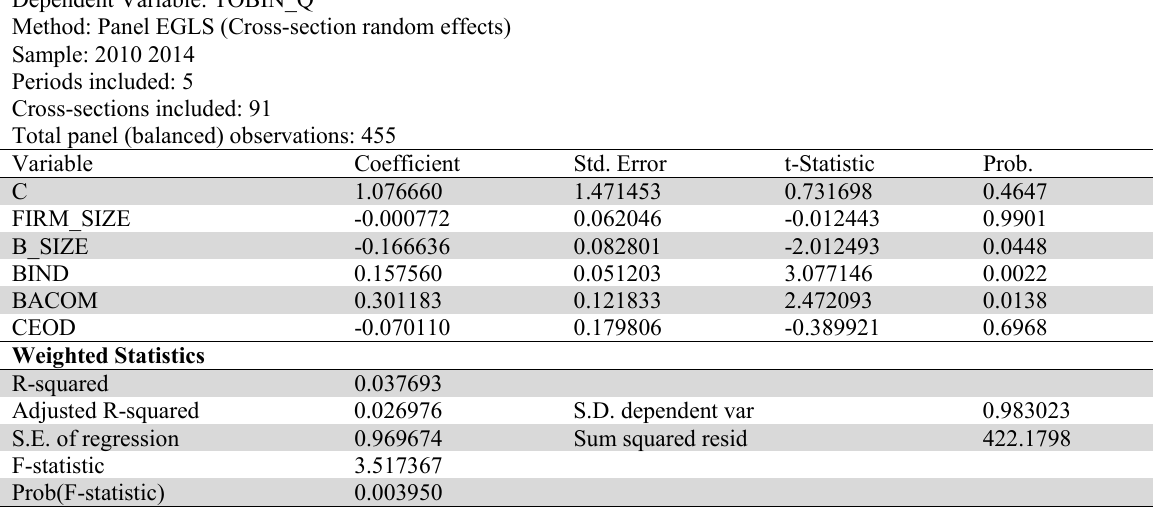
Results of Panel